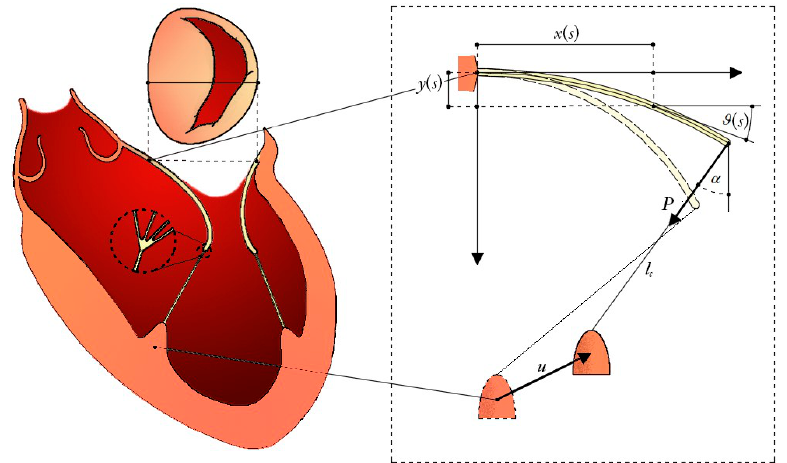
Figure 3. Hand-made sketch of the in-plane mechanical modelling of the mitral valve nonlinear bending combined with tethering due to the interaction with hyperelastic chordae anchored to the moving PM site.